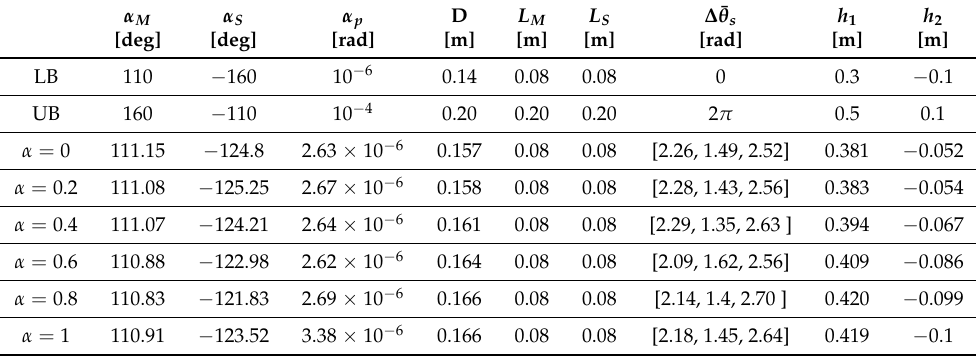
Table A4. The resulting (optimized) parameter values of co-design case 4 given variable weight α